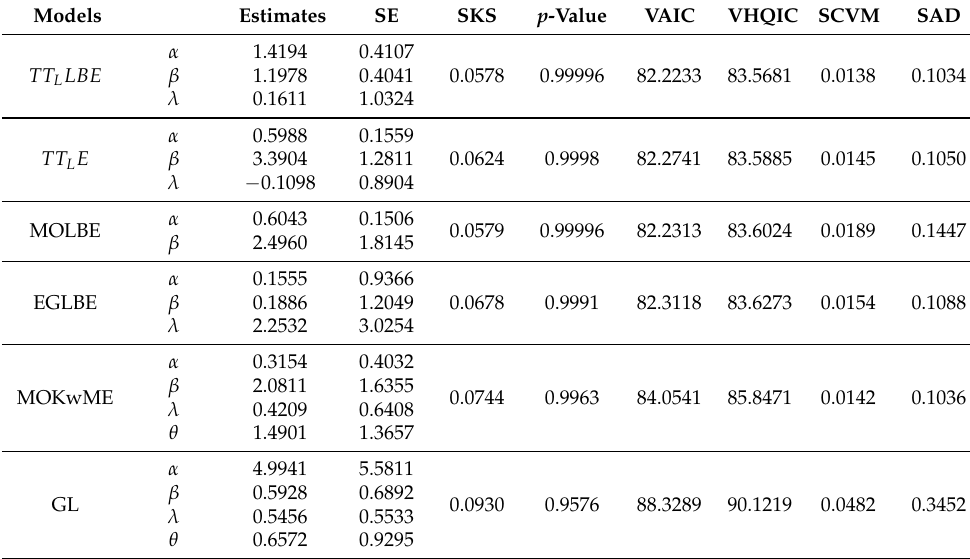
Table 7. MLE with SE, SKS test with p -value and different measures for data set I.